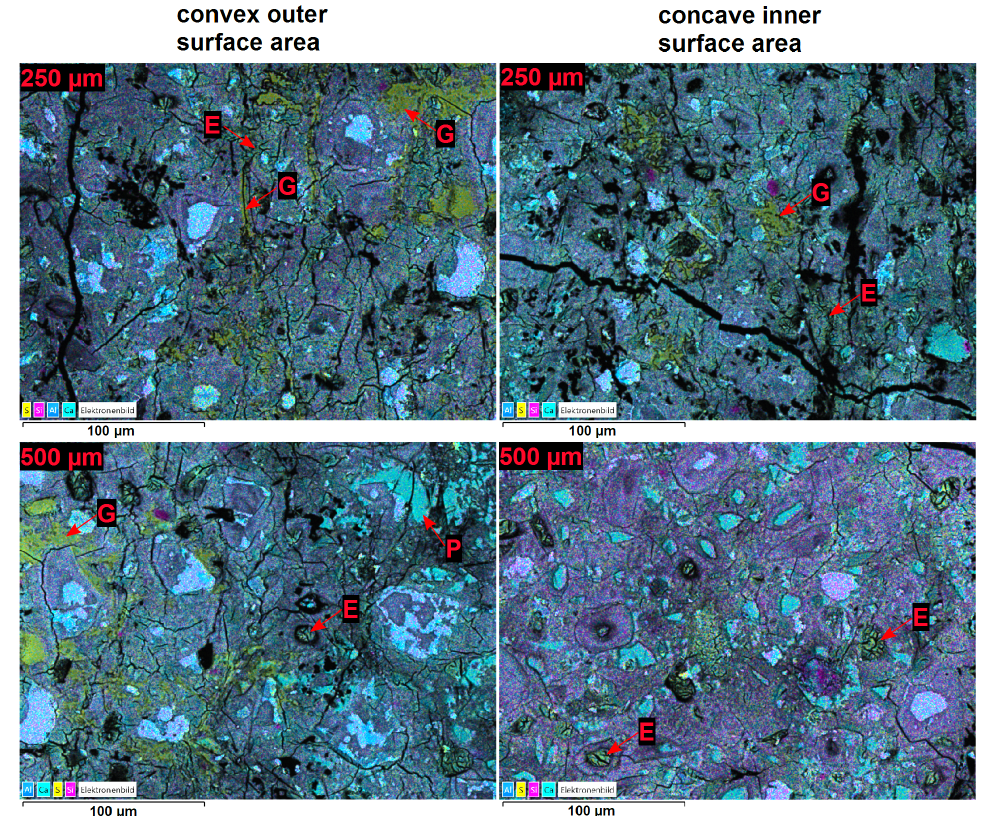
Figure 9. Overlay maps of BSE images with the EDS element maps of calcium, silicon, aluminium and sulphur of the microstructure over the cross-section of hollow cylinder walls (OPC H) at the time of mechanical failure of the samples after 59 days (constrained stress cell) of storage in 3.0gL SO 2– 4 . The sample depth was 250µm or 500µm, respectively. The following phases are indicated in the figure: E: ettringite; G: gypsum; P: